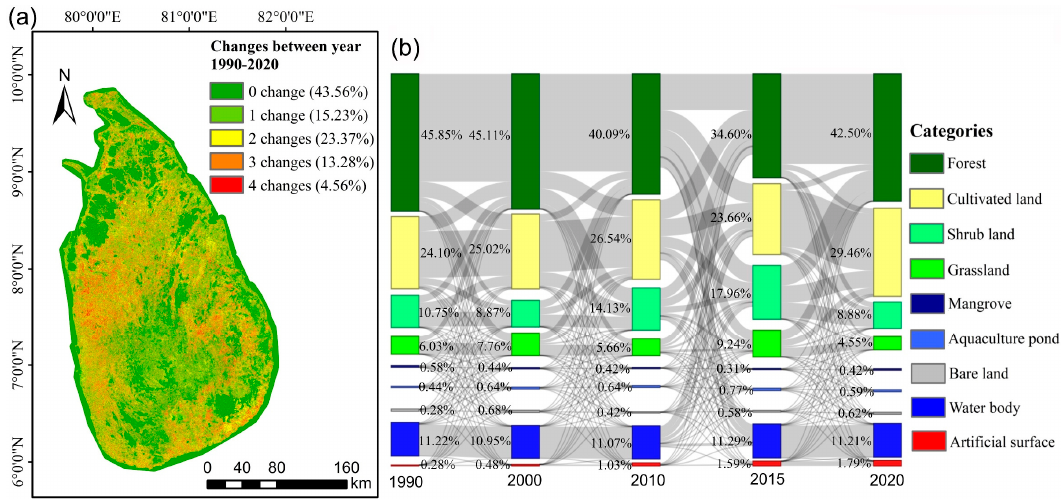
Figure 3. Changes in Sri Lanka from 1990 to 2020. ( a ) Land cover changes and ( b ) change flows between different land cover types.